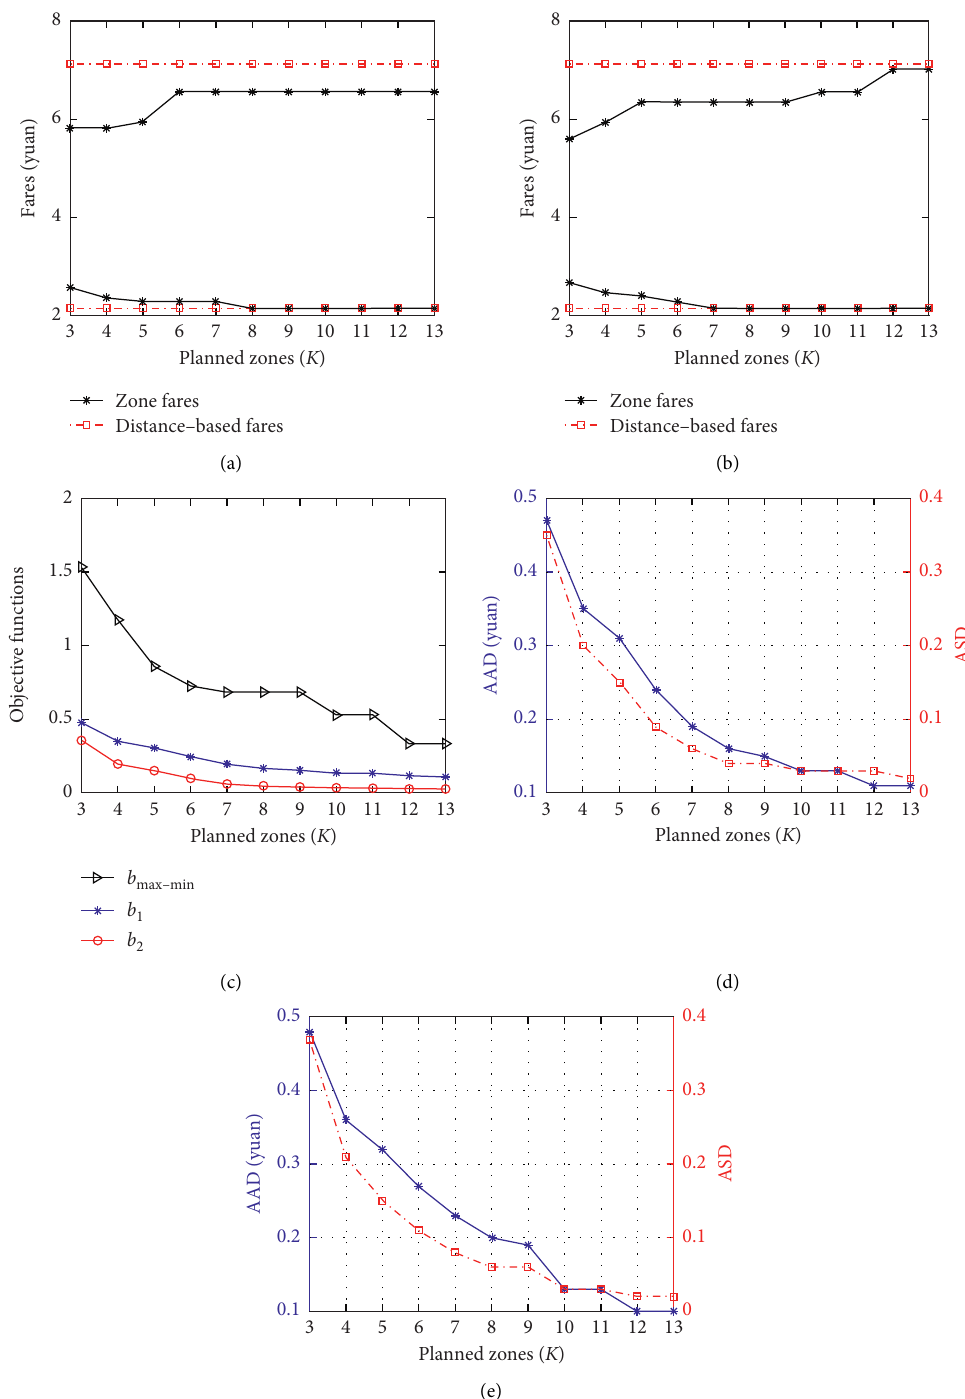
Figure 6: Analysis under objective functions b b . (c) Objective functions. (d) AAD and ASD under b max − min